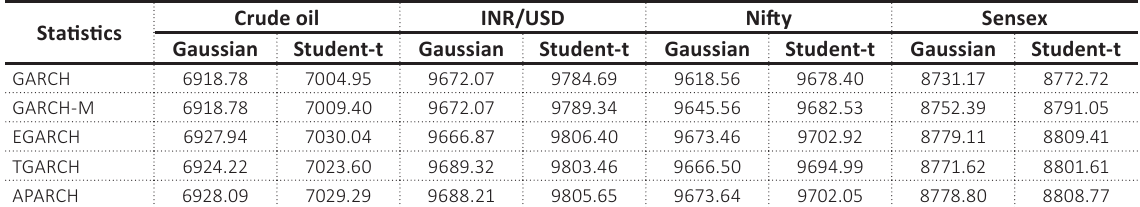
Table A1. Log likelihood comparison of different asymmetric models under Gaussian and Student-t